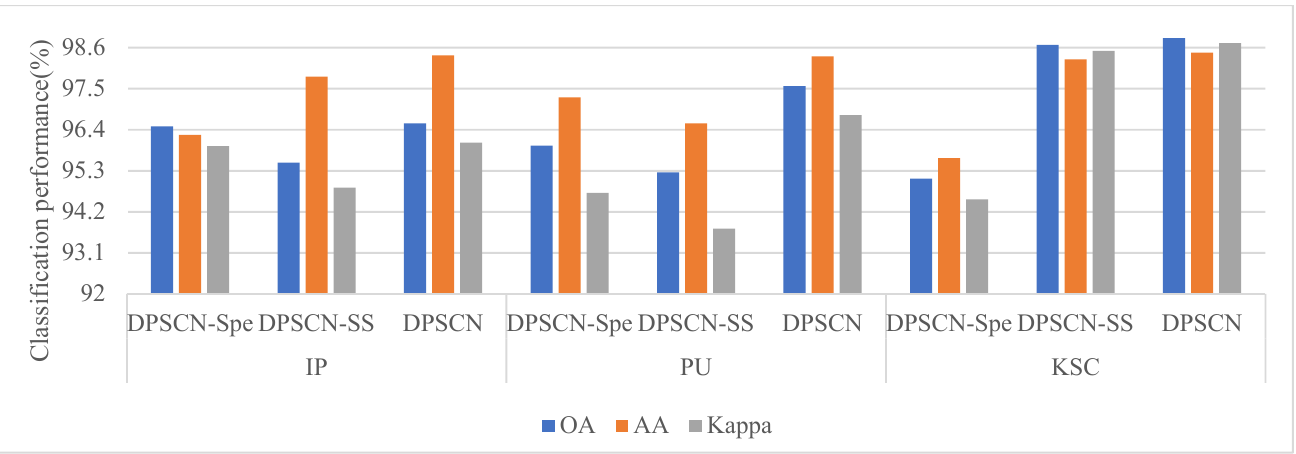
Figure 12. Classification performance of the classification network with the different feature learning block.